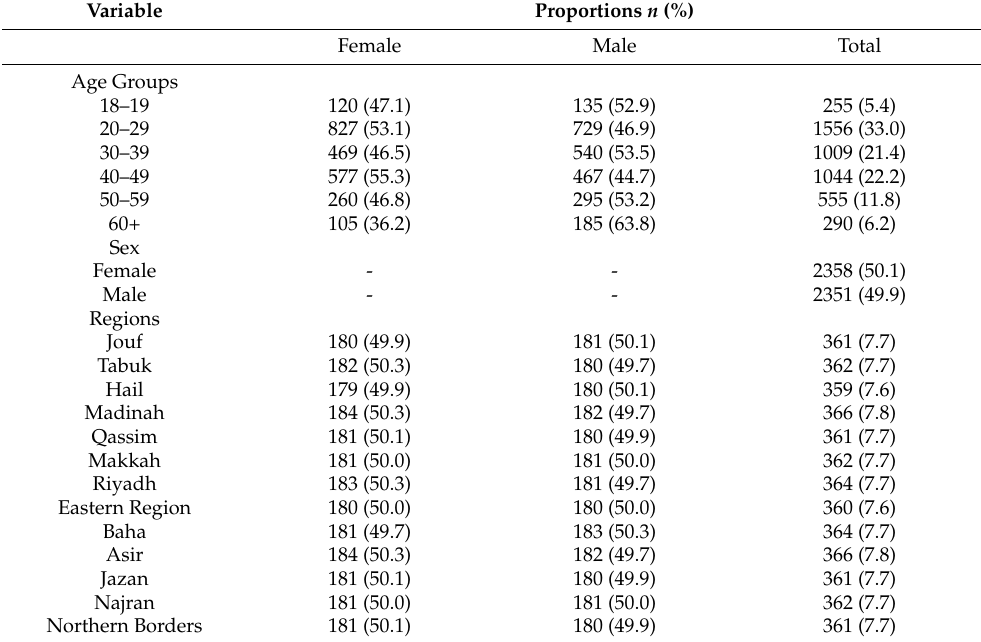
Table 1. Demographic characteristics of participants.